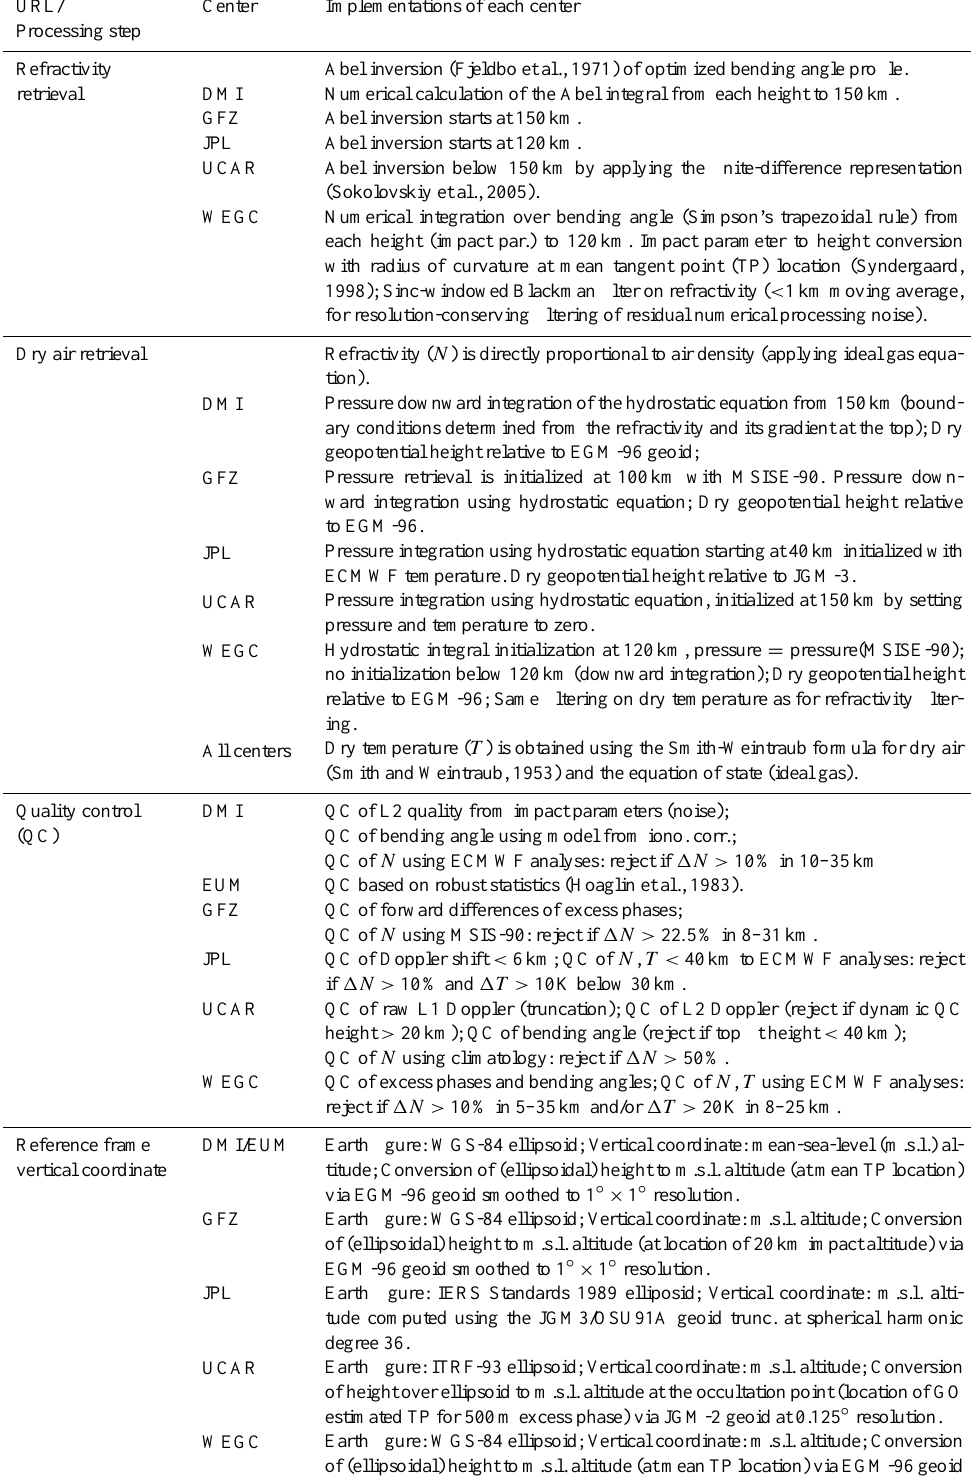
Earth figure: WGS-84 ellipsoid; Vertical coordinate: mean-sea-level (m.s.l.) al- titude; Conversion of (ellipsoidal) height to m.s.l. altitude (at mean TP location) via EGM-96 geoid smoothed to 1 ◦ × 1 ◦ resolution. Earth figure: WGS-84 ellipsoid; Vertical coordinate: m.s.l. altitude; Conversion of (ellipsoidal) height to m.s.l. altitude (at location of 20km impact altitude) via EGM-96 geoid smoothed to 1 ◦ × 1 ◦ resolution. Earth figure: IERS Standards 1989 elliposid; Vertical coordinate: m.s.l. alti- tude computed using the JGM3/OSU91A geoid trunc. at spherical harmonic degree 36. Earth figure: ITRF-93 ellipsoid; Vertical coordinate: m.s.l. altitude; Conversion of height over ellipsoid to m.s.l. altitude at the occultation point (location of GO estimated TP for 500m excess phase) via JGM-2 geoid at 0.125 ◦ resolution. Earth figure: WGS-84 ellipsoid; Vertical coordinate: m.s.l. altitude; Conversion of (ellipsoidal) height to m.s.l. altitude (at mean TP location) via EGM-96 geoid smoothed to 2 ◦ × 2 ◦